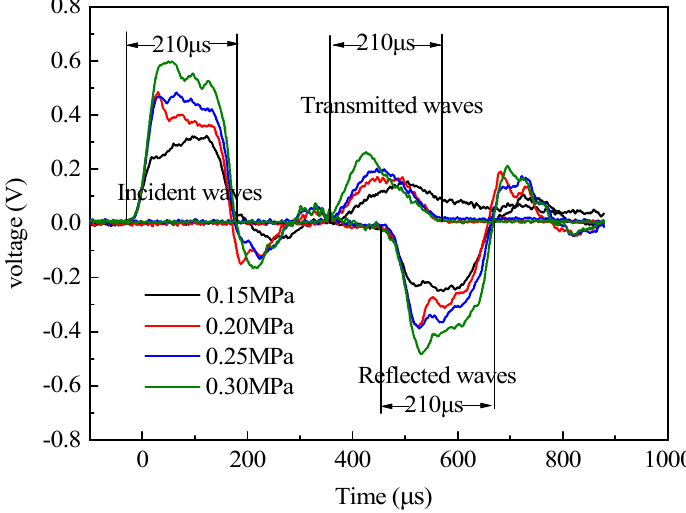
Figure 4. Typical voltage time-history curves.